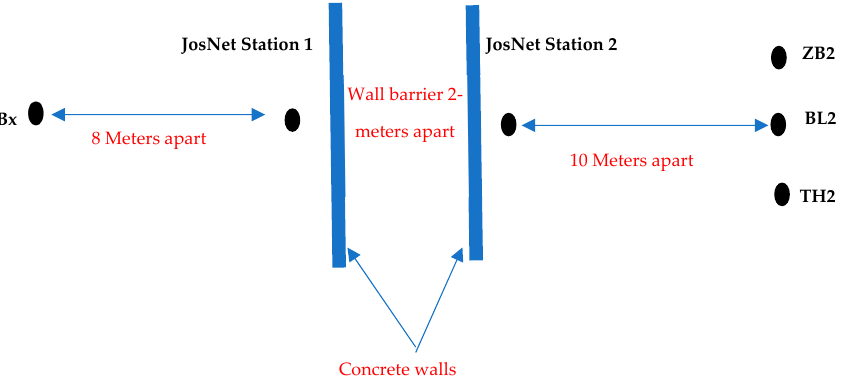
Figure 17. Schematic representation of the nodes separated by 2 concrete walls for the Zigbee–All connection pair.